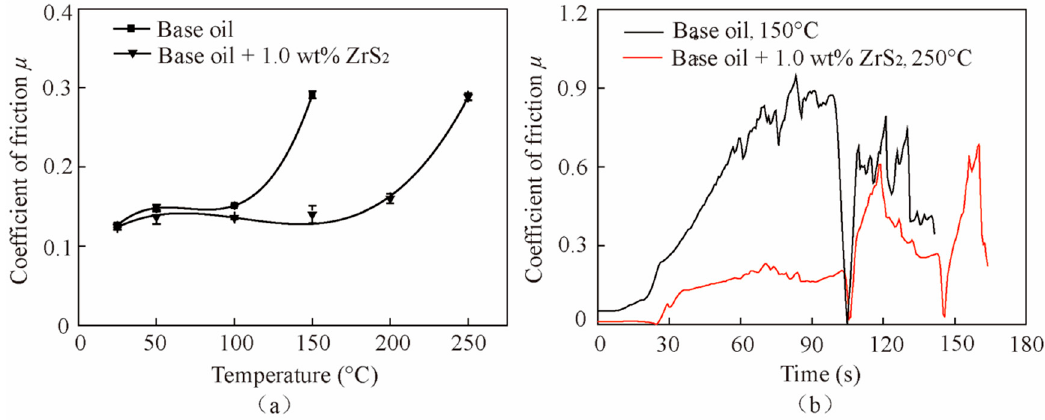
Figure 12. Friction coefficient of the base oil and that with 1.0 wt% ZrS 2 additives with different temperatures: ( a ) average friction coefficient and ( b ) typical friction coefficient curves above the critical temperature.